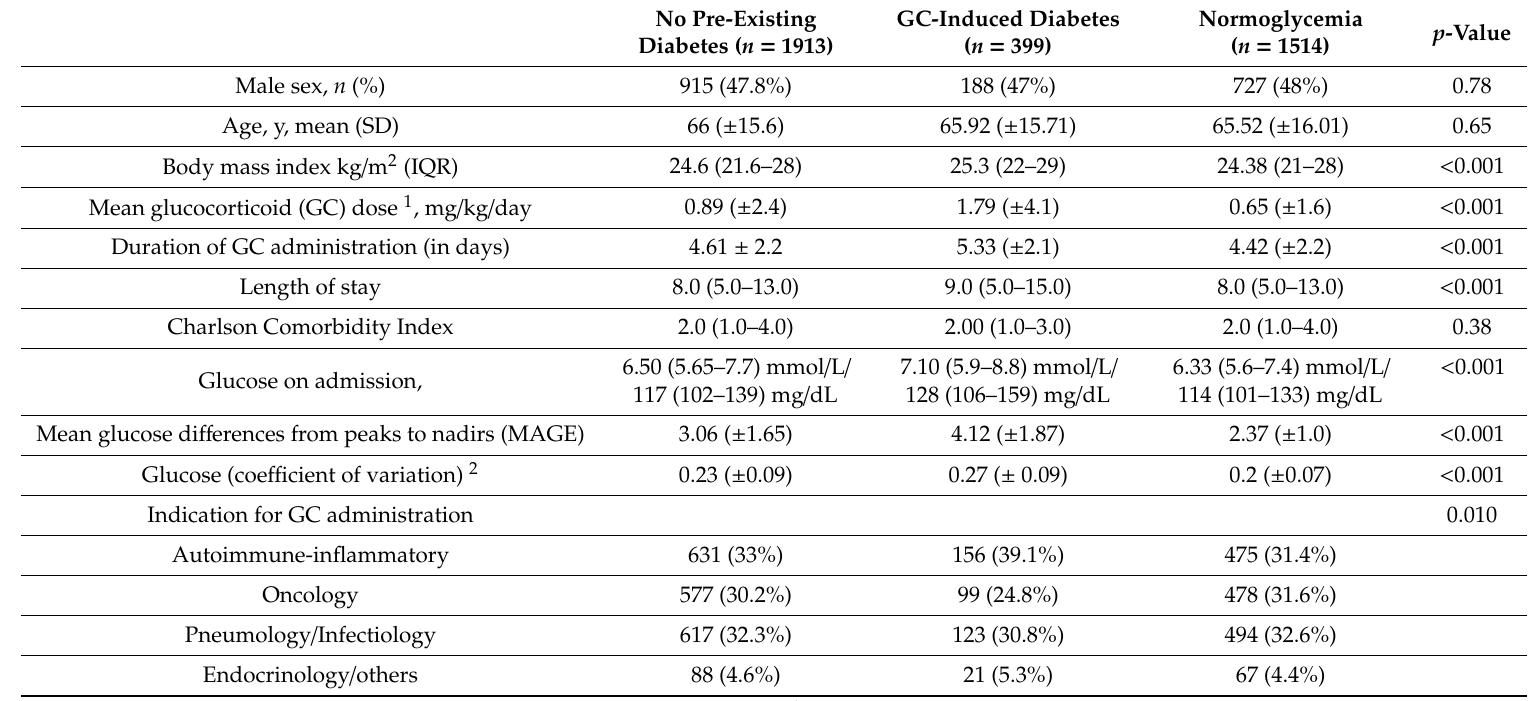
Table A1. Baseline characteristics of all patients with GC-induced diabetes vs. patients with